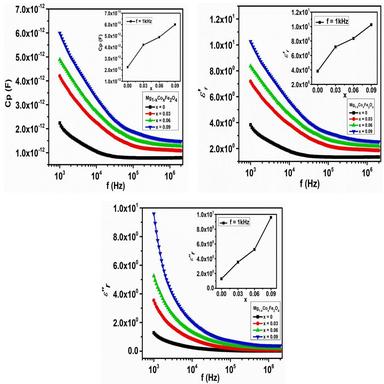
(a-c): Variation of dielectric parameters (a) Capacitance, (b) Real part, (c) Imaginary part, of Mg1-xCoxFe2O4 with (x = 0, 0.03, 0.06, and 0.09) nanoparticles, while insets show variations of Co concentrations versus respective dielectric parameters.